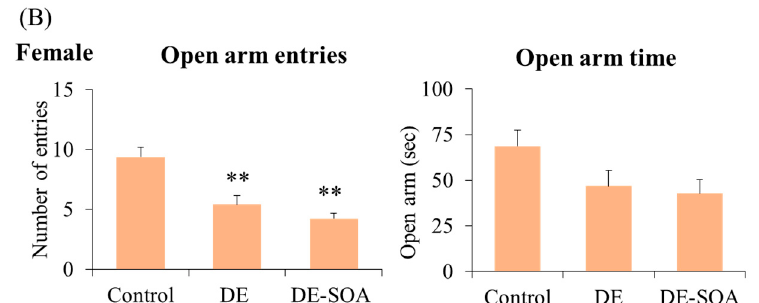
Figure 3. Elevated plus maze test. Number of entries to the open arm and time spent in the open arm in 10-week-old ( A ) male and ( B ) female rats of the control and the DE- or DE-SOA-exposed groups ( n = 10, ** p < 0.01, * p < 0.05 vs. corresponding control).